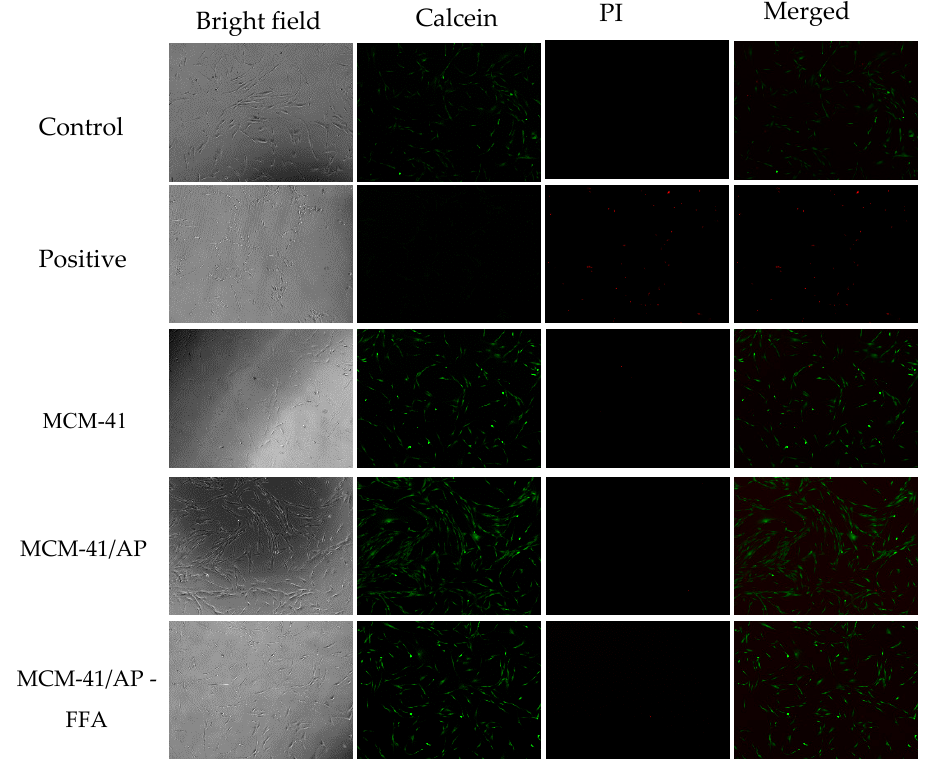
Figure 11. Images from fluorescence microscopy for all groups. Calcein (green) for viable (alive) cells, and propidium–iodide (PI) (red) for dead cell staining. Table 5. Zeta potential and hydrodynamic size of MCM-41, MCM-41/AP, and